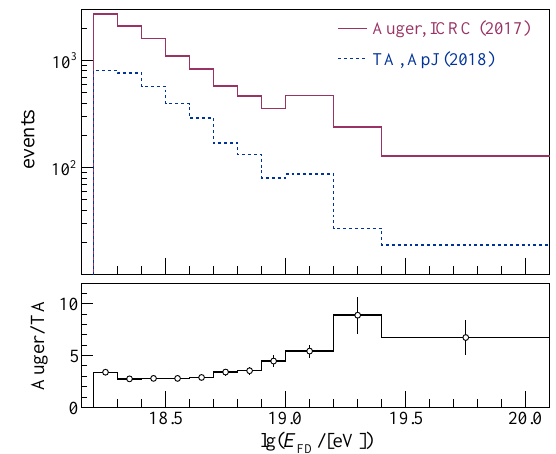
Figure 4. Numbers of events (top) and their ratio (bottom) in the X max data sets of Auger [9] and TA BR / LR [6] for the common energy range E > 10 18 . 2 eV. The energy binning is the same as used by the TA [6]. Data are binned using the energy scales of each of the experiments.